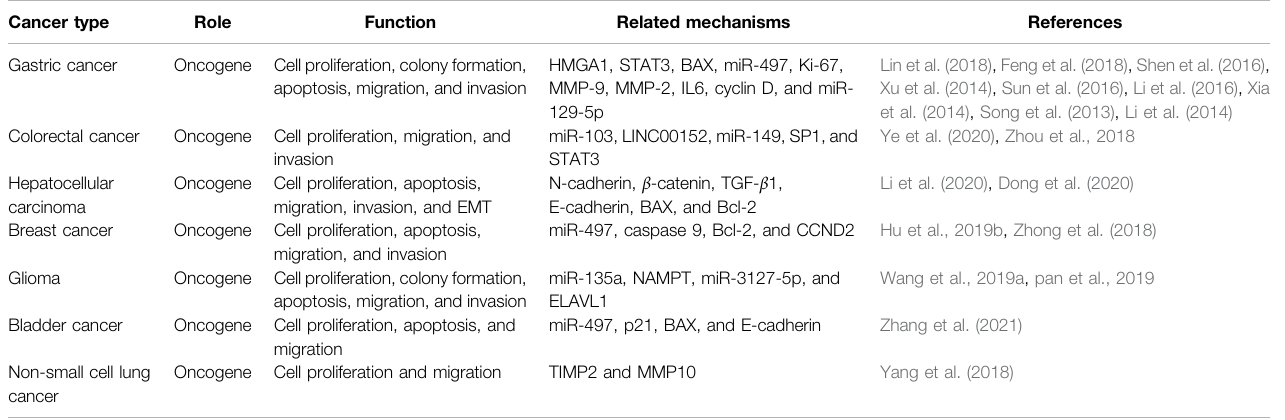
TABLE 2 | The function and related mechanisms of